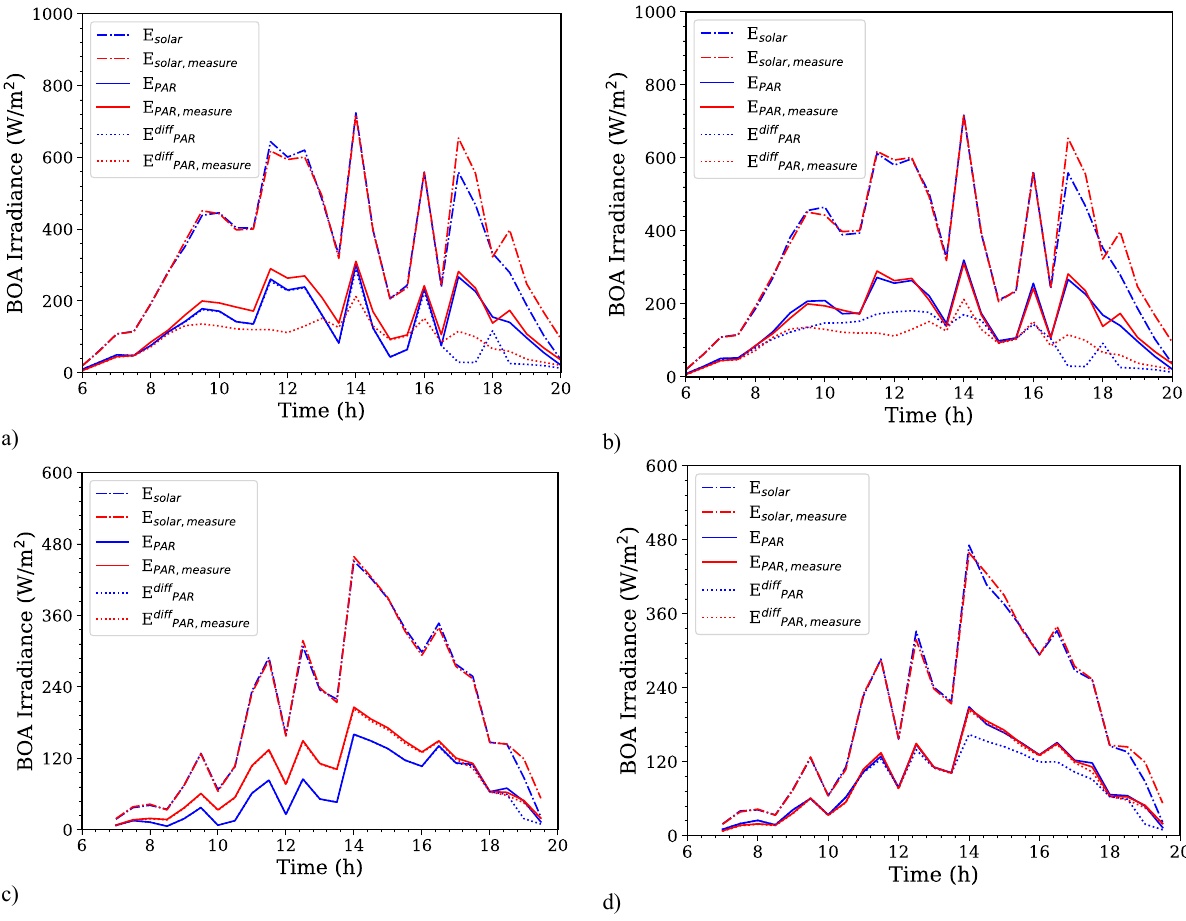
Figure 3. Measured (red) and simulated (blue) BOA irradiance in solar and PAR spectral domains, on July 14, 2016 (a, b) and on August 18, 2016 (c, d). DART atmosphere is configured without clouds (a, c) and with clouds (b, d).